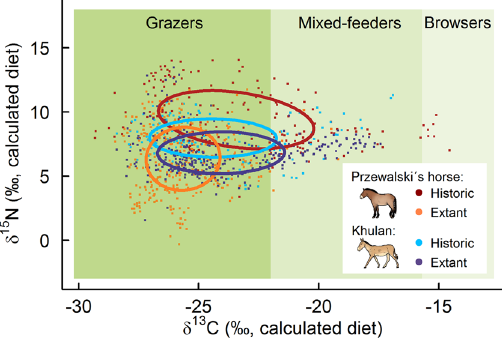
Figure 3. Core isotopic dietary niches of reintroduced, extant and historic Przewalski’s horses and sympatric historic and extant khulan in the Dzungarian Gobi. Artwork: M. van